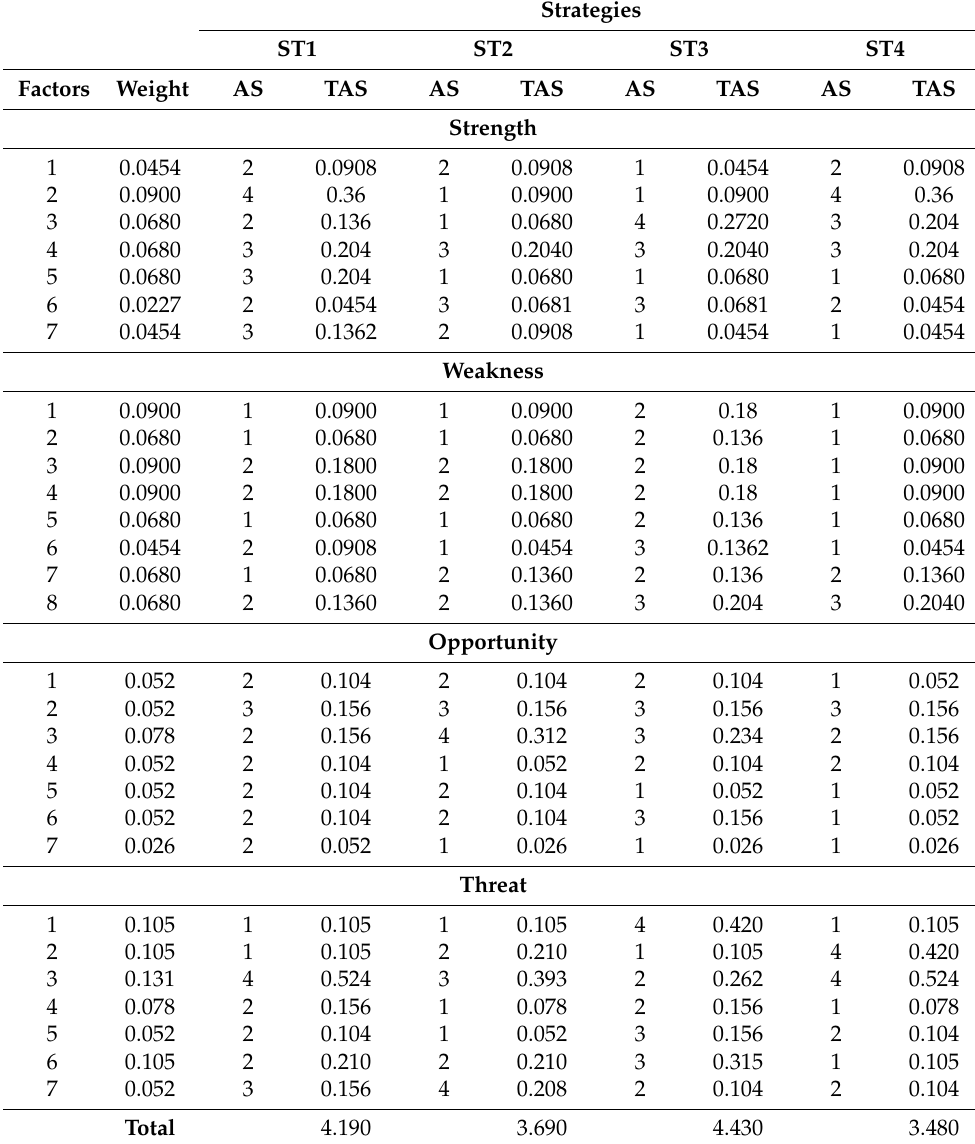
Table 18. Quantitative Strategies Planning Matrix (QSPM). AS represents attraction scores and TAS the total attraction